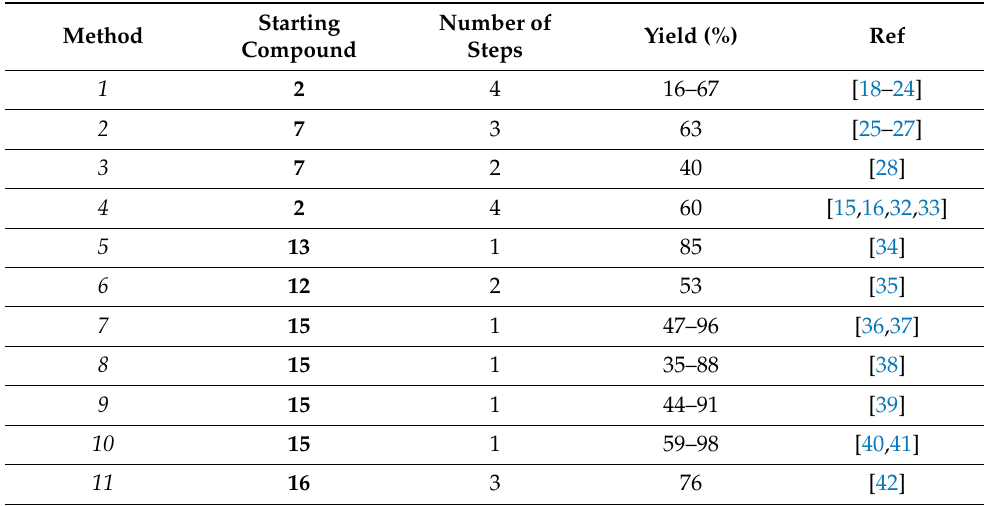
Table 1. Synthetic procedures for ebselen 1 and its